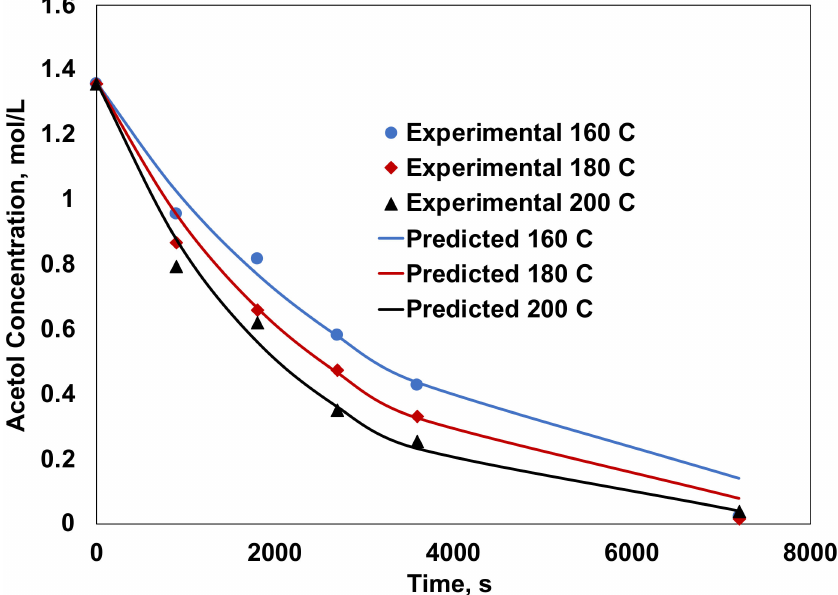
Figure A7. Concentration of acetol over the reaction time of acetol hyydrogenation at different temperatures.